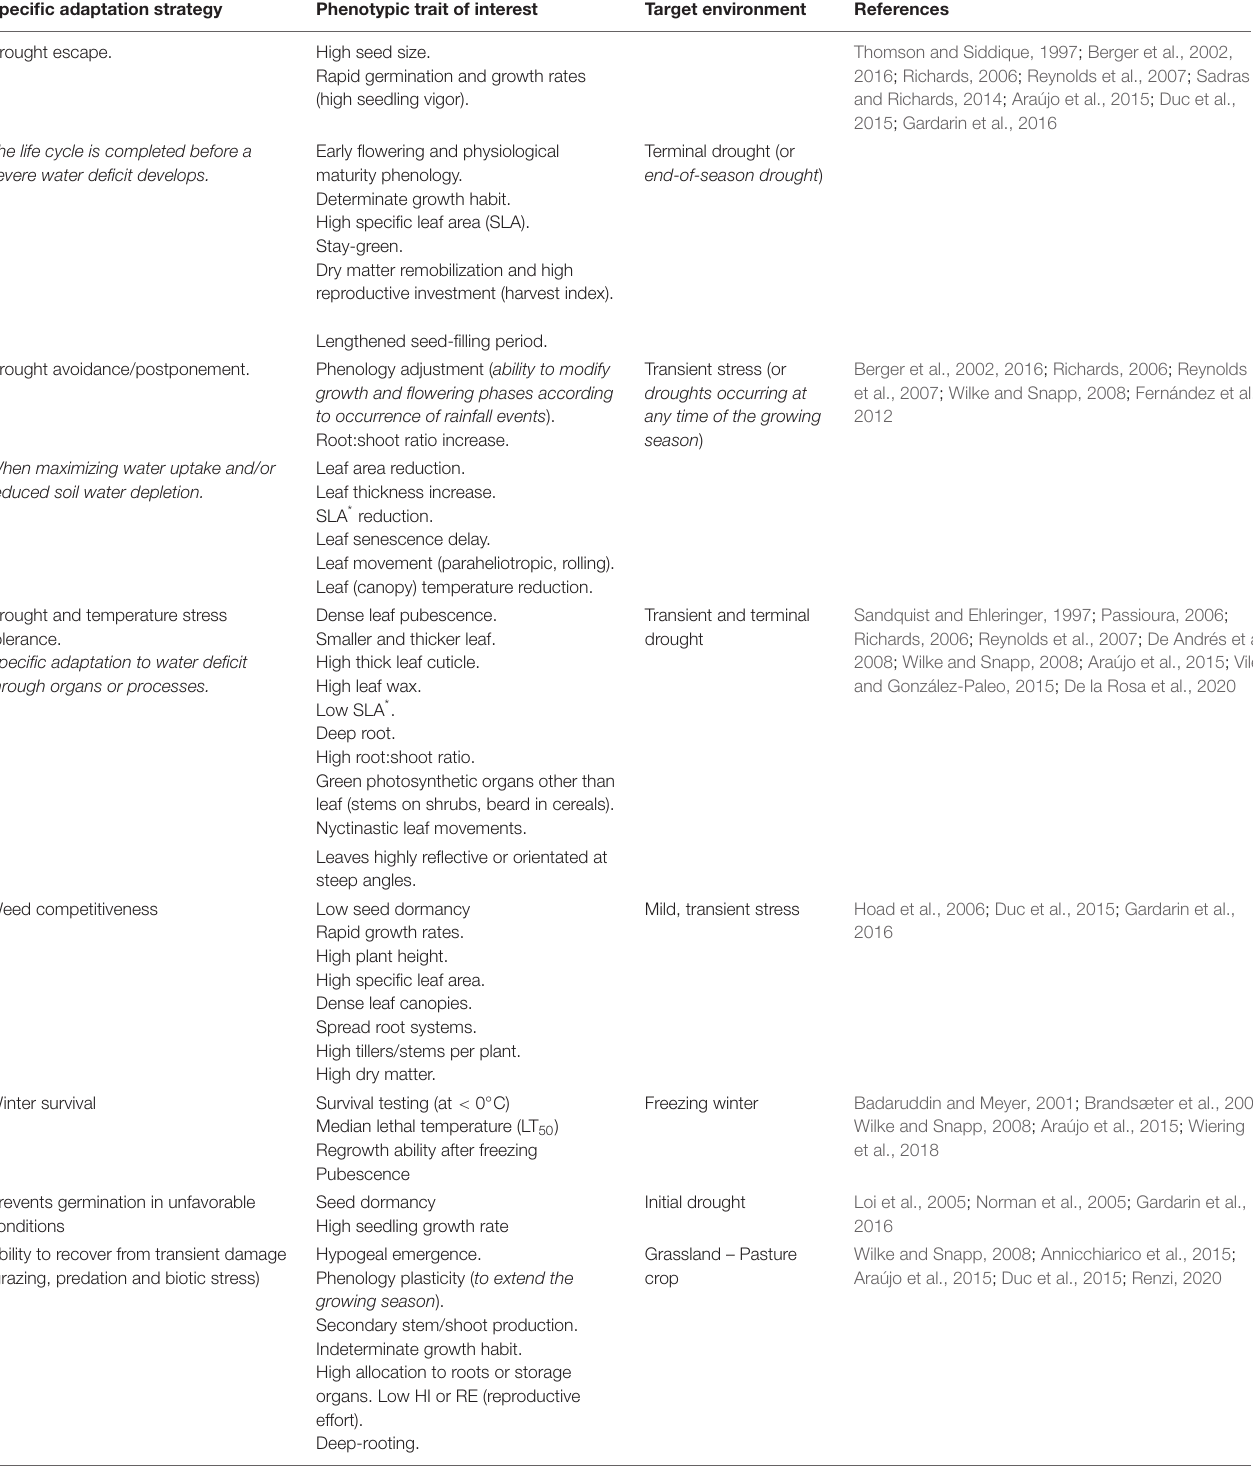
TABLE 1 | Linking phenotypic traits and adaptation strategies that could be used as pre-breeding criteria in a population improvement program in grain and pasture crops. Specific adaptation